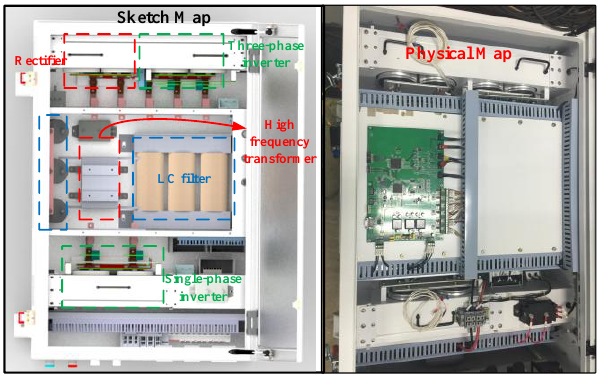
Figure 15. The auxiliary converter.